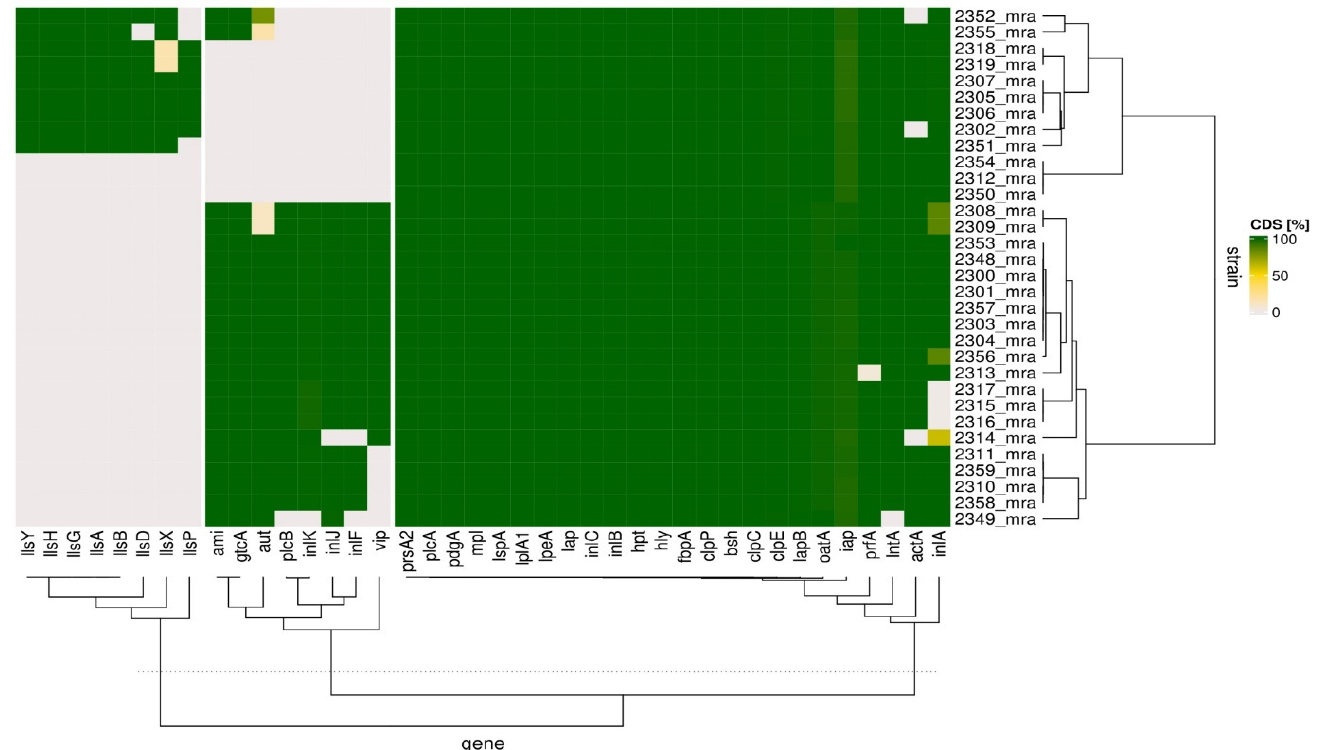
Figure 3. Clustering analysis of virulence genes in L. monocytogenes isolates. The heatmap shows the presence of the selected virulence gene set among the analyzed isolates. Normalized coding sequence (CDS) lengths are shown in colors.